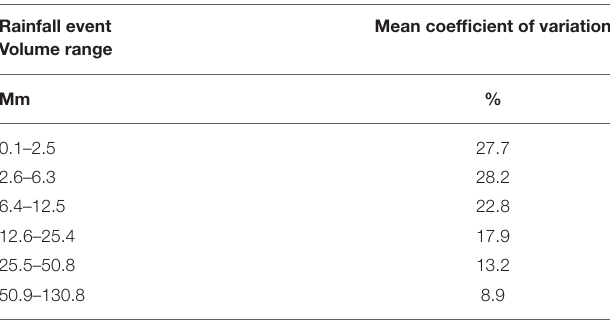
TABLE 3 | Variations in the coefficient of variation of rain volume captured per rainfall event. Rainfall event Volume